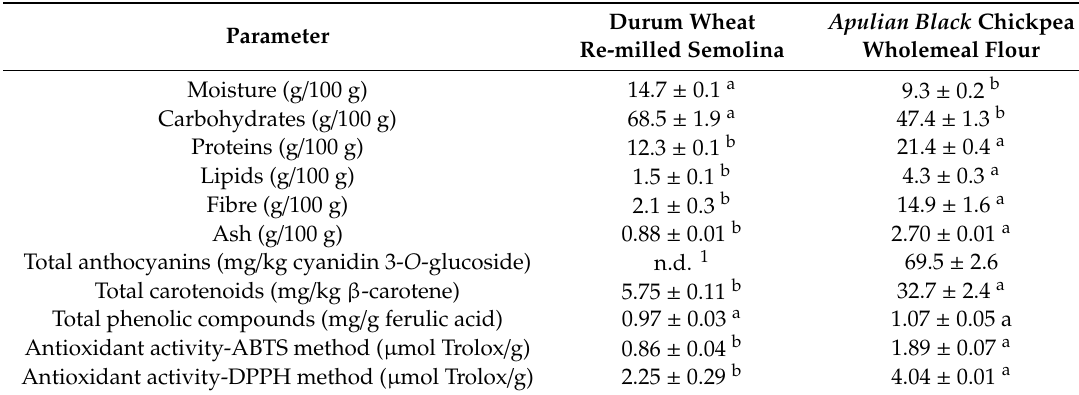
Table 2. Nutritional characteristics, bioactive compounds, and antioxidant activities of flours used in the production of experimental bread, pizza crust, and focaccia (values are expressed on fresh weight